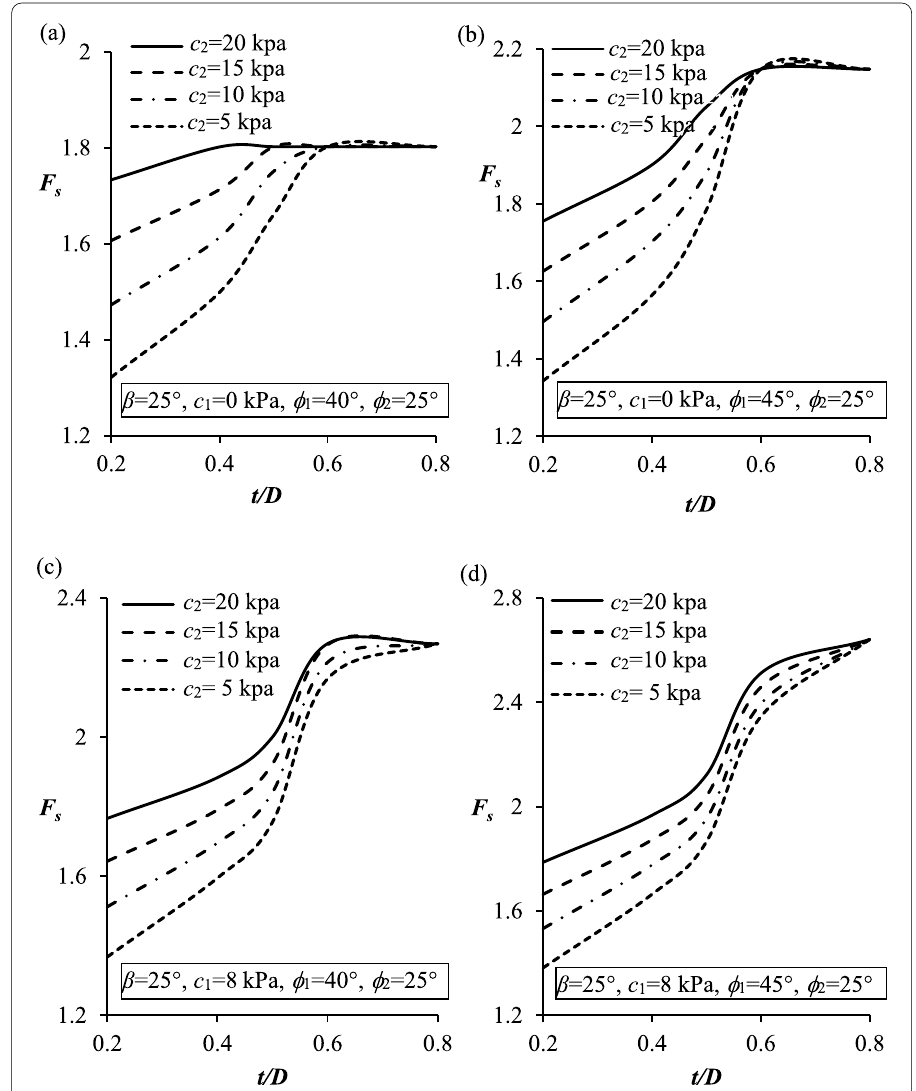
Fig. 2 The variation of F s with t/D for a two-layered slope ( β